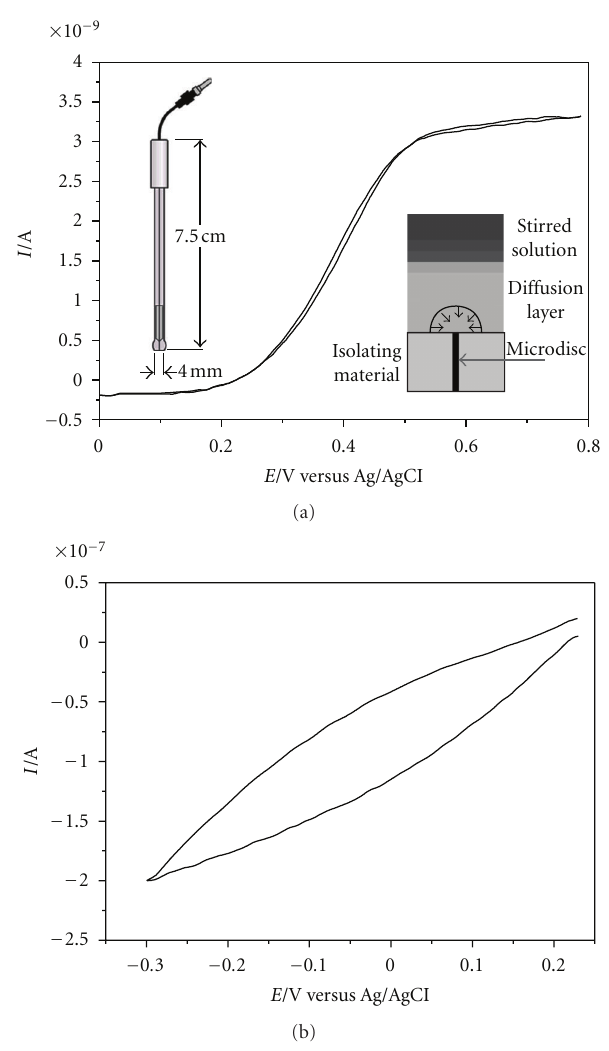
Figure 5: Ultramicroelectrode voltametry (a) without, and (b) with MWNTs. The inserted figures give a graphic representation of an ultramicroelectrode. Graphic representations of an ultramicroelec- trode are shown.